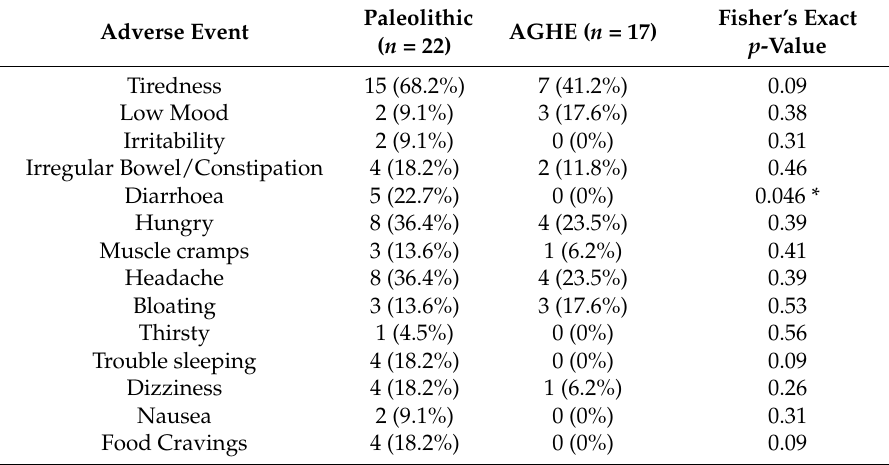
Table 2. Proportion of participants who reported adverse events by dietary intervention group. Adverse